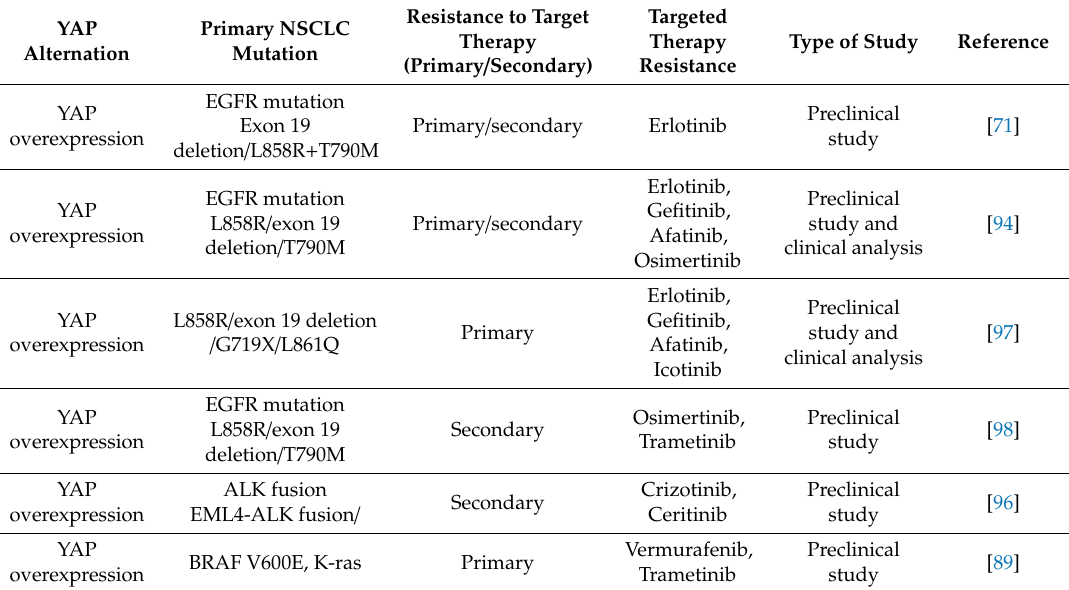
Table 2. YAP-related resistance to targeted therapy in